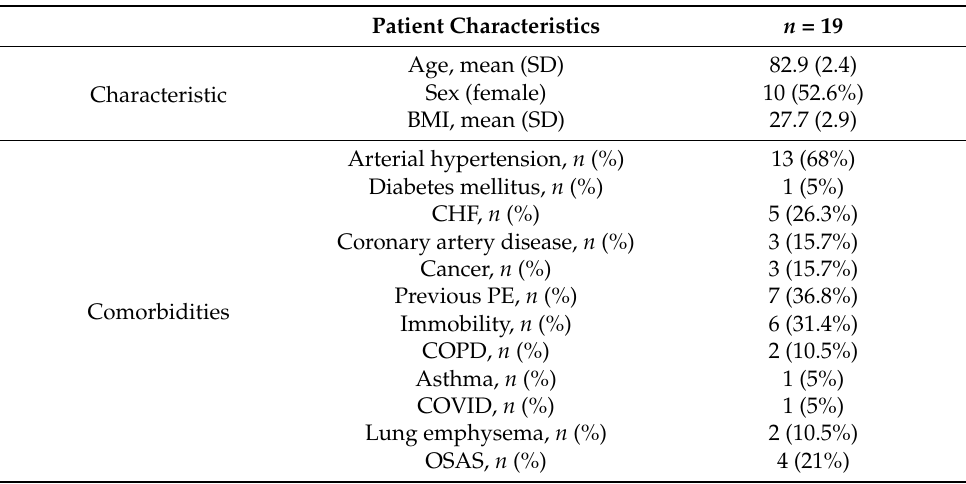
Table 1. Baseline characteristics. BMI: body mass index, OSAS: obstructive sleep apnoea syndrome, COPD: chronic obstructive pulmonary disease, CHF: chronic heart failure, PE: pulmonary embolism, and SD: standard deviation.